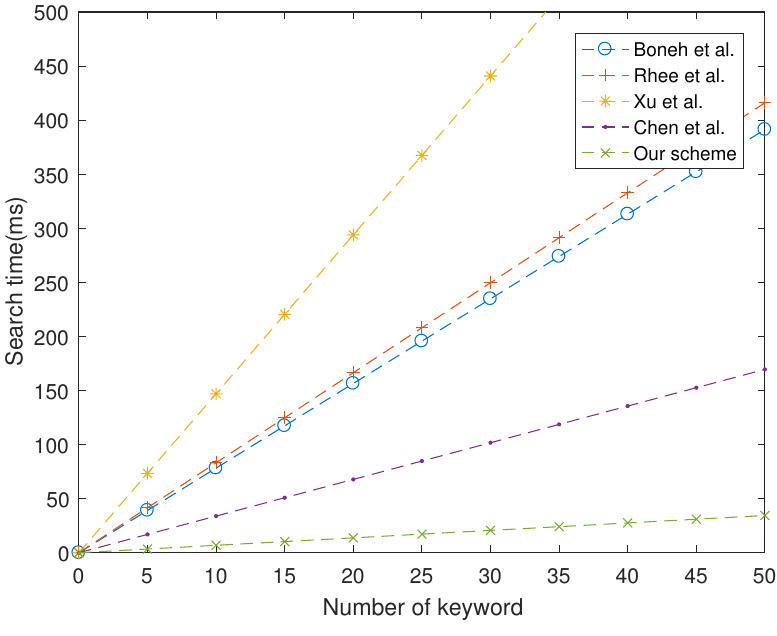
Figure 3. Computation cost at search